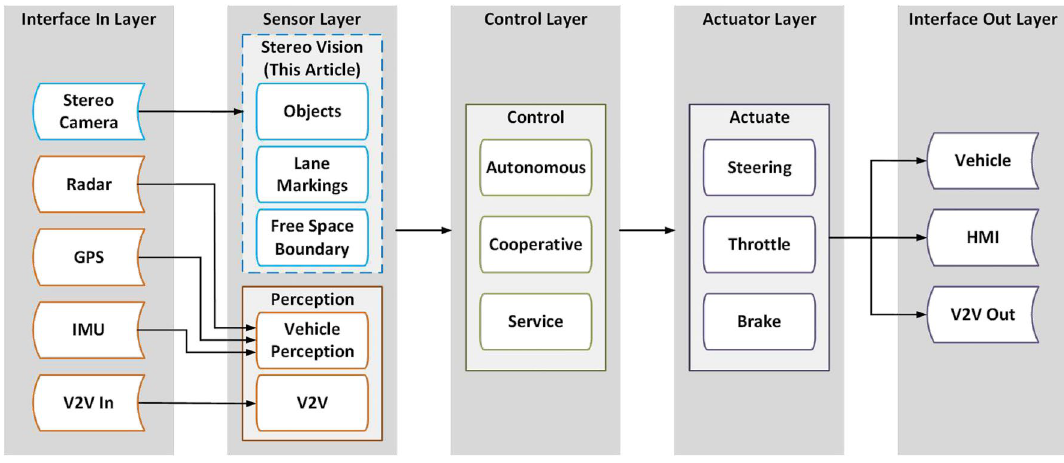
Fig. 2 Automated vehicle functional architecture